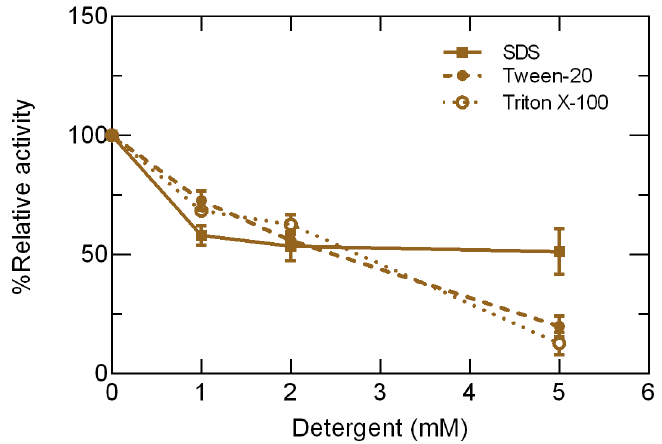
non-ionic detergents Tween-20 and Triton X-100. The errors bars represent SD values for three